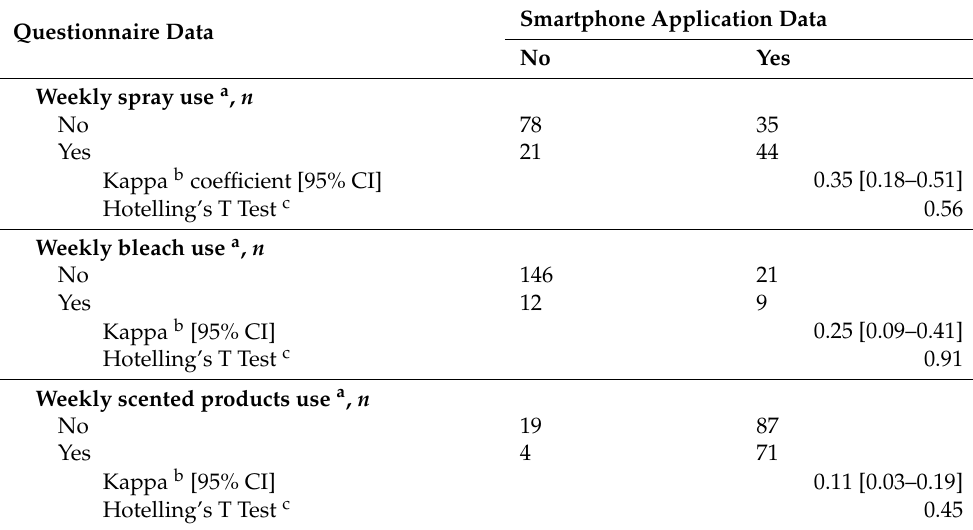
Table 3. Comparison of HDCPs assessed by questionnaire and smartphone application, all data collection points ( n =